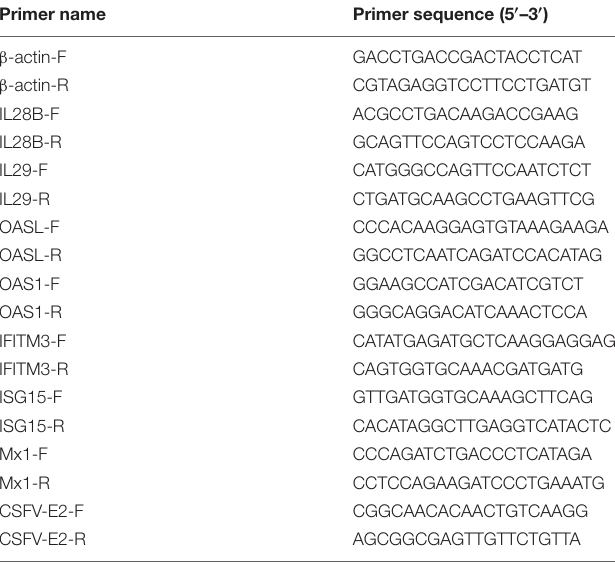
TABLE 1 | Primer sequences used in this